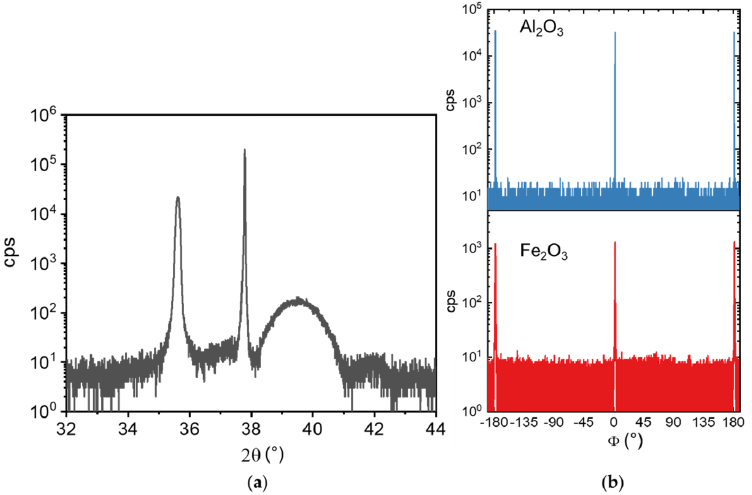
Figure 4. ( a ) XRD θ –2 θ patterns of the α -Fe 2 O 3 epitaxial film grown on an [ 1120 ] Al 2 O 3 substrate. ( b ) XRD Φ -scan results of the α -Fe 2 O 3 and Al 2 O 3 reflections.